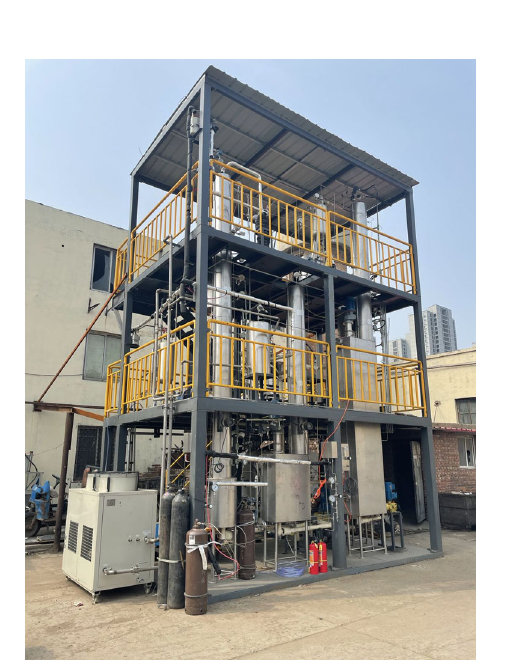
Fig. 7 | The physical picture of the pilot plant for continuous C4 gas mixture sorption – desorptionseparationexperiment. Themainbodyoftheequipmentis twopackedcolumns,whichareusedasabsorptioncolumnanddesorptioncolumn respectively, with a height of about 5.5